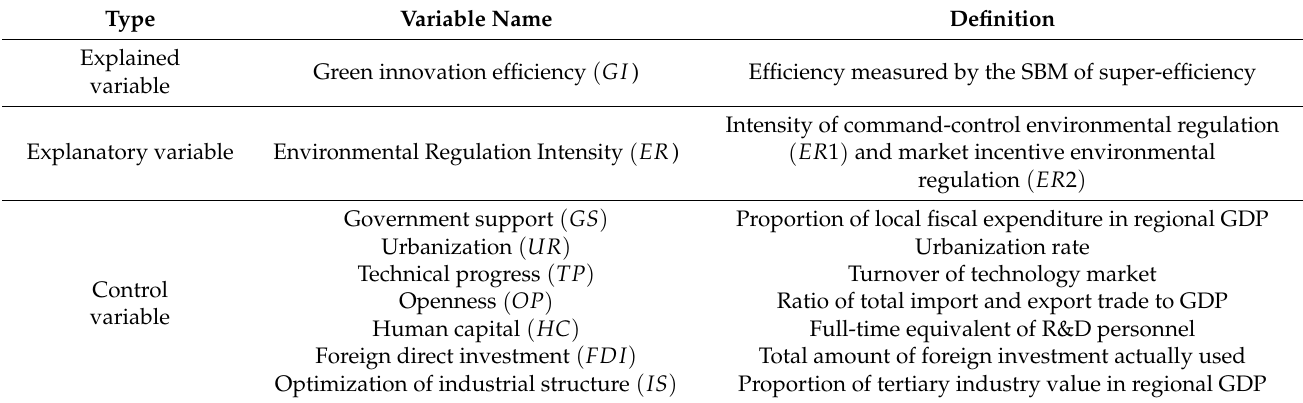
Table 3. Variable